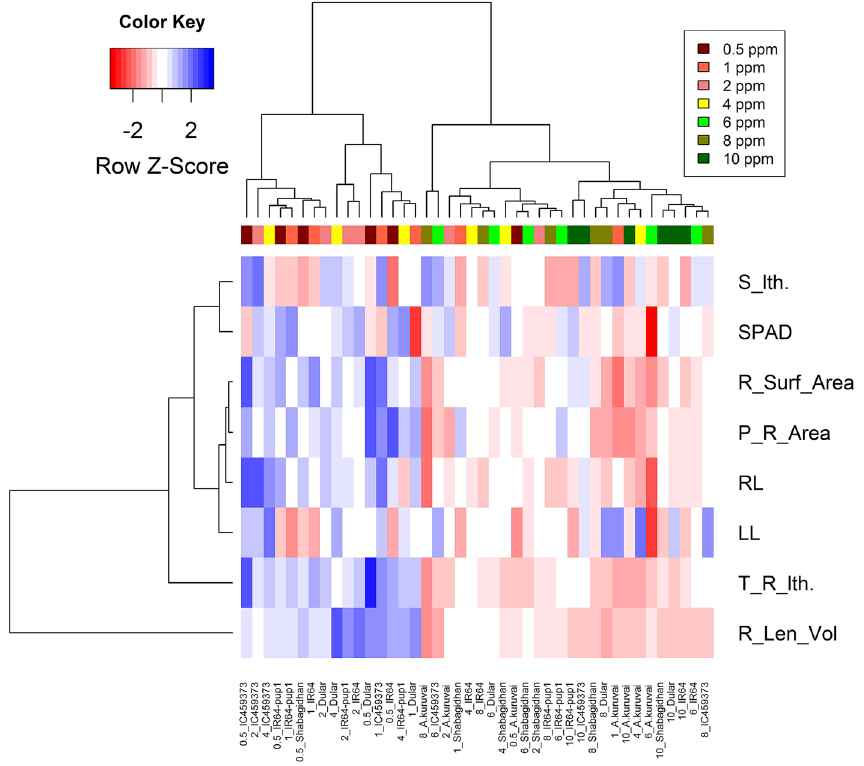
Figure 9. Heat map showing the grouping of genotypes based on similarity in expression of root and shoot vigor under different concentrations of P at 14 d. S_lth: shoot length (cm); SPAD; R_Surf_Area: root surface area (cm 2 ); P_R_Area: projected root area (cm 2 ); RL: max. root length (cm); LL: leaf length (cm); T_R_lth: total root length (cm); R_Len_Vol: root length per